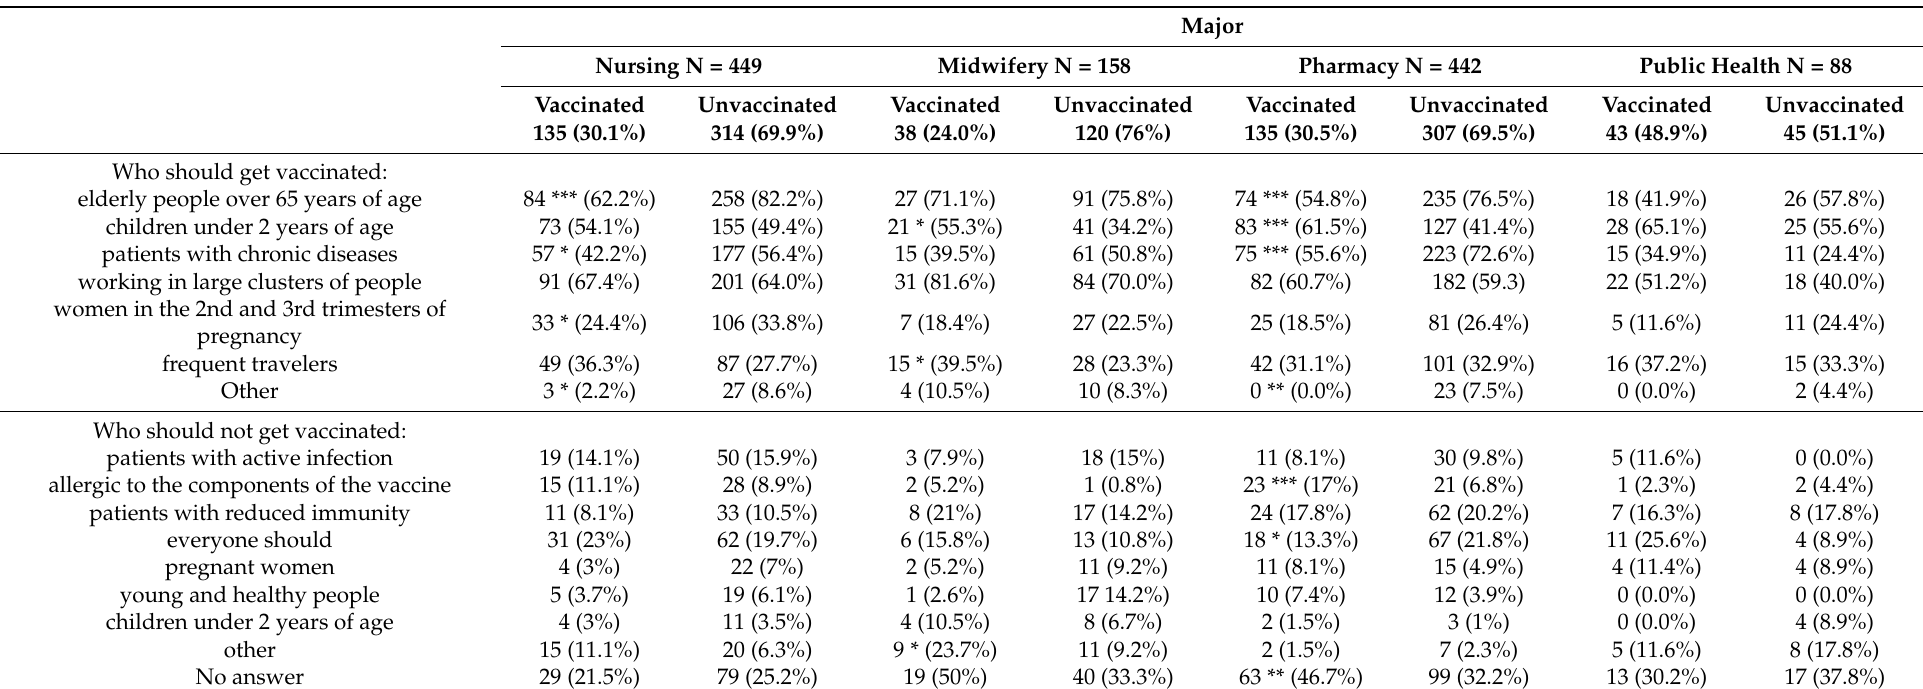
Table 3. Recommendations and contraindications for influenza vaccination among vaccinated and unvaccinated students from four majors: Nursing, Midwifery, Pharmacy, and Public